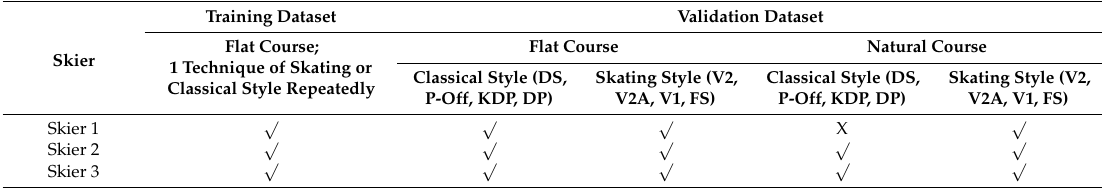
Table 3. Training and validation data collected for three professional skiers characterized by the type of course (flat/natural) and the number and type of skiing techniques (classical/skating) that the subject is allowed to perform